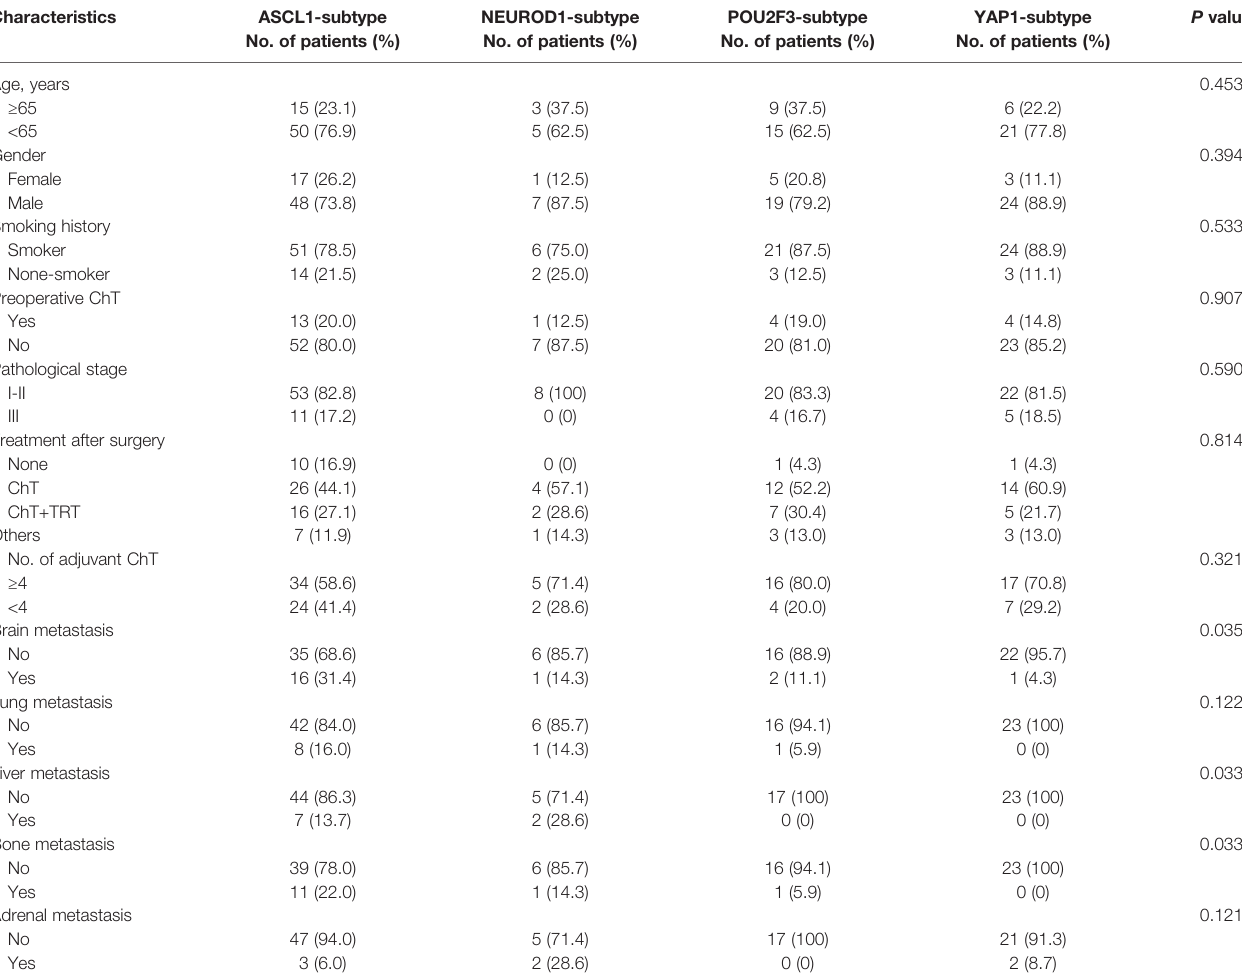
TABLE 2 | Comparison of baseline clinicopathologic characteristics among molecular subtypes of primary SCLC tumors in FFPE cohort.